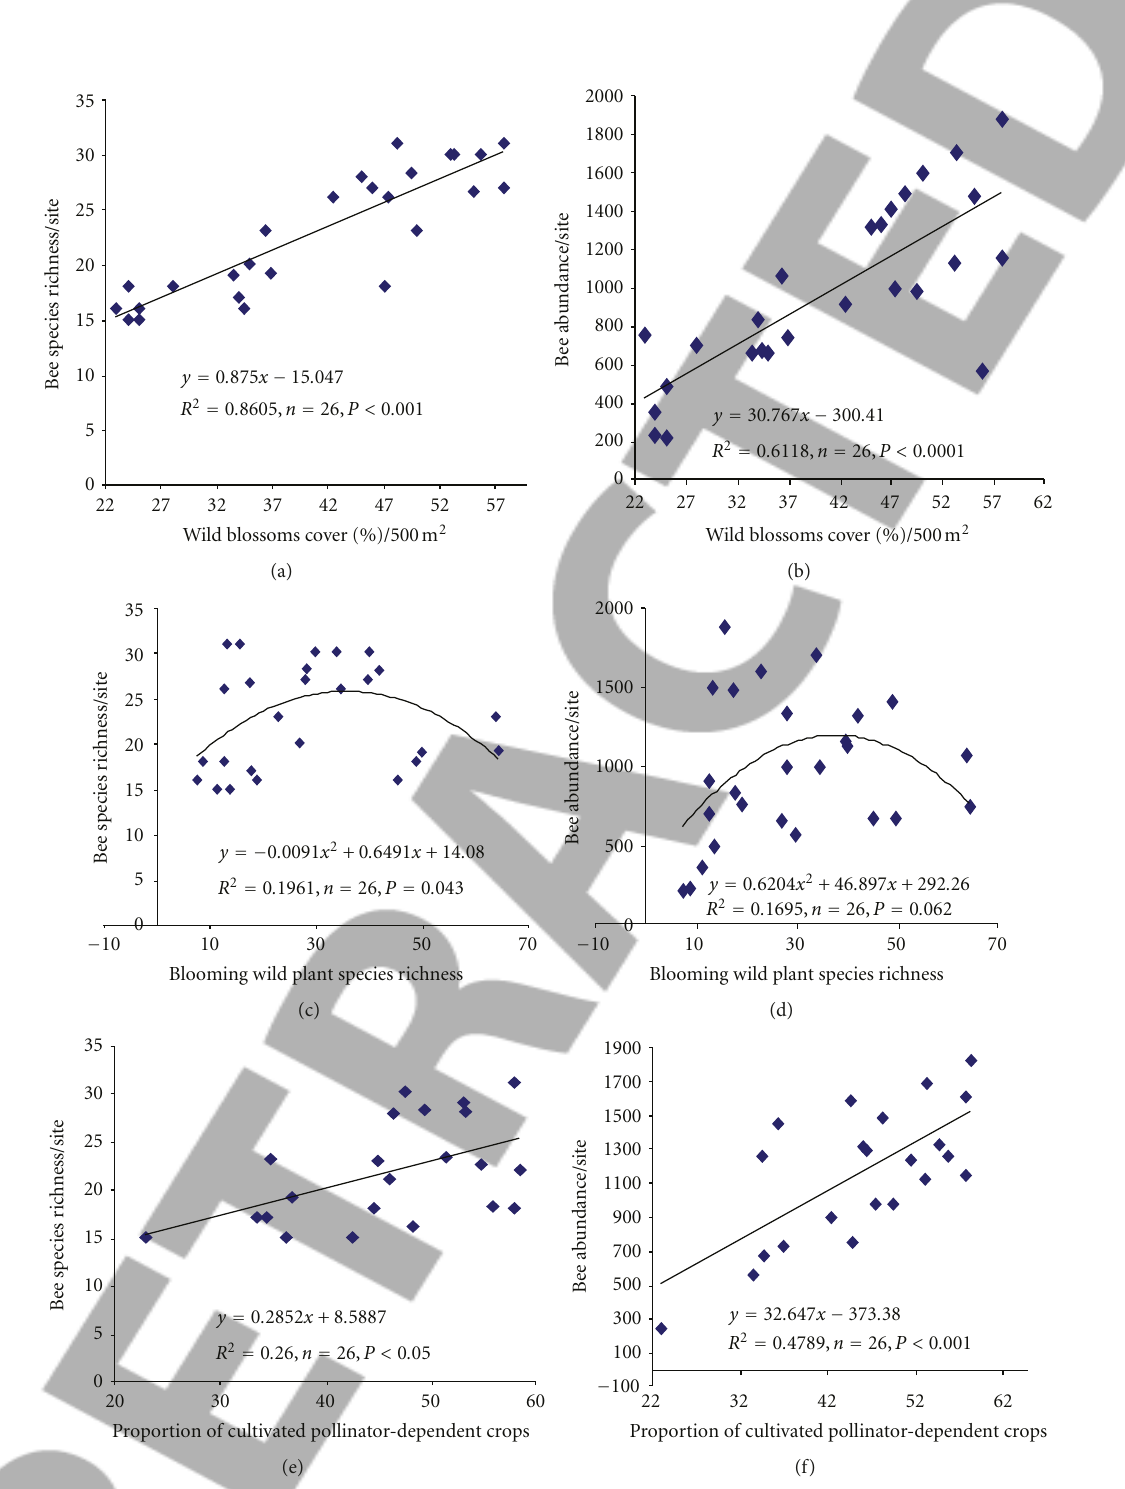
Figure 3: Relationship between (i) the abundance of wild floral resources (% blossoms cover), (ii) the abundance of cultivated floral resources (% of cultivated pollinator-dependent crops: all annual, bi-annual, perennial entomophilous crop species potentially offering pollen-nectar to bees), (iii) the number of flowering plant species (weeds, herbs, trees, and shrubs), and the number of bee species (a, c, and e) and bee abundance (b, d, and e) per study